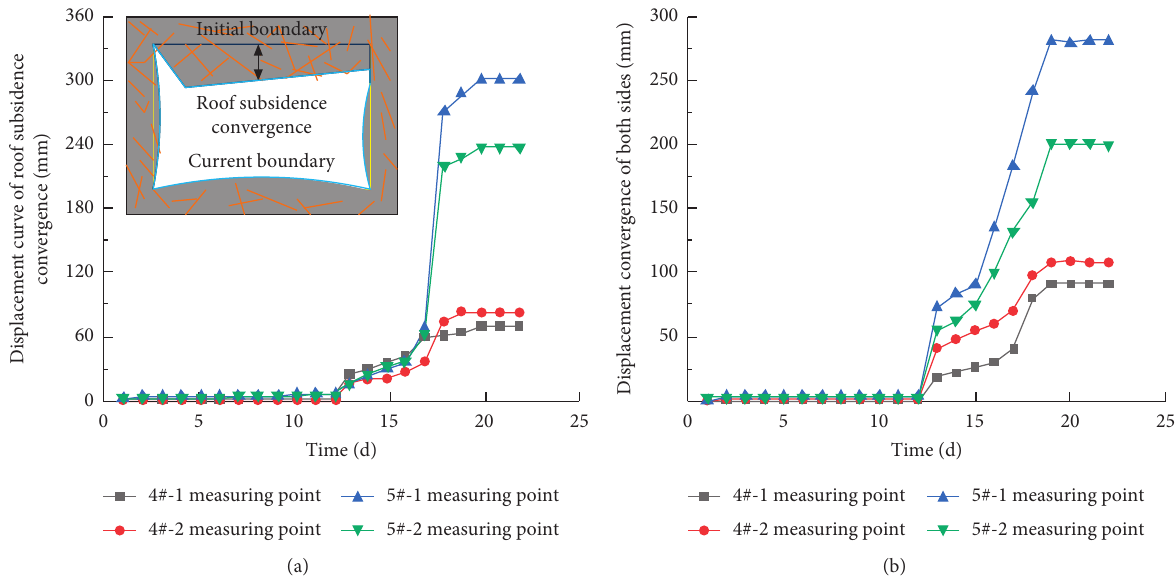
Figure 7: Displacement curve of the roadway surface: (a) displacement curve of roof subsidence convergence; (b) displacement convergence of both sides.